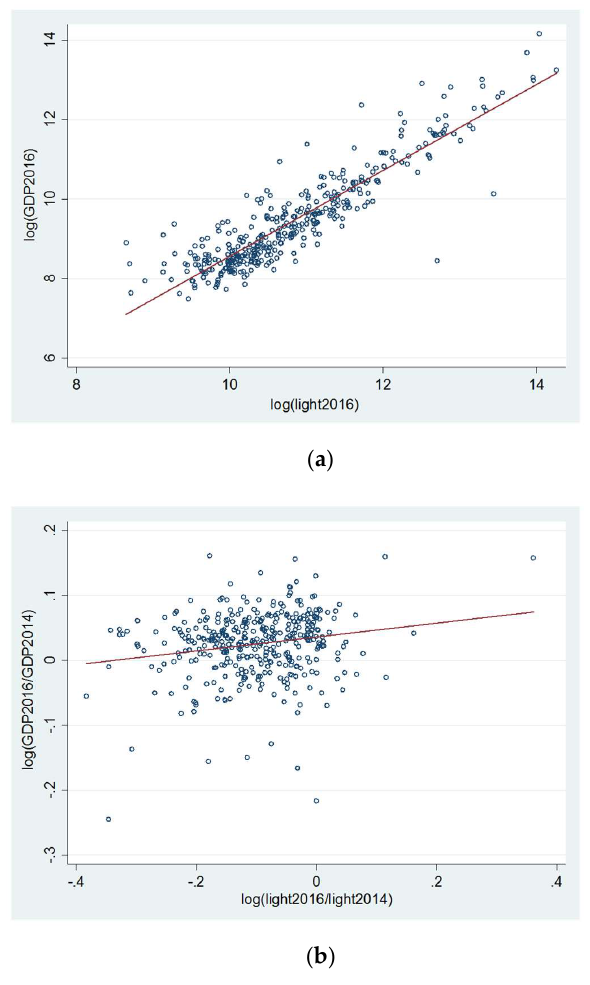
Figure 3. MSA lights (average monthly composites) and GDP annual data (2016) ( a ) and for 2-year growth (2014–2016) ( b